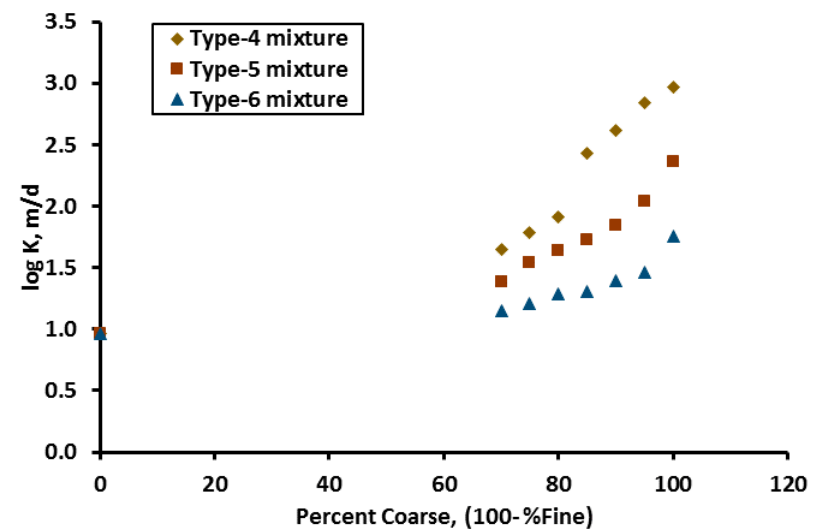
Figure 4. Increase in the effective hydraulic conductivity values (K values plotted in log scale) of Type- 4 (K c = 920 m/day and K f = 9 m/day), Type-5 (K c = 228 m/day and K f = 9 m/day), and Type-6 (K c = 57 m/day and K f = 9 m/day) fine-coarse mixtures. The seven mixtures for each type were prepared by varying the coarse porous media content (percentage by weight) as: 0%, 70%, 75%, 80%, 85%, 90%, and